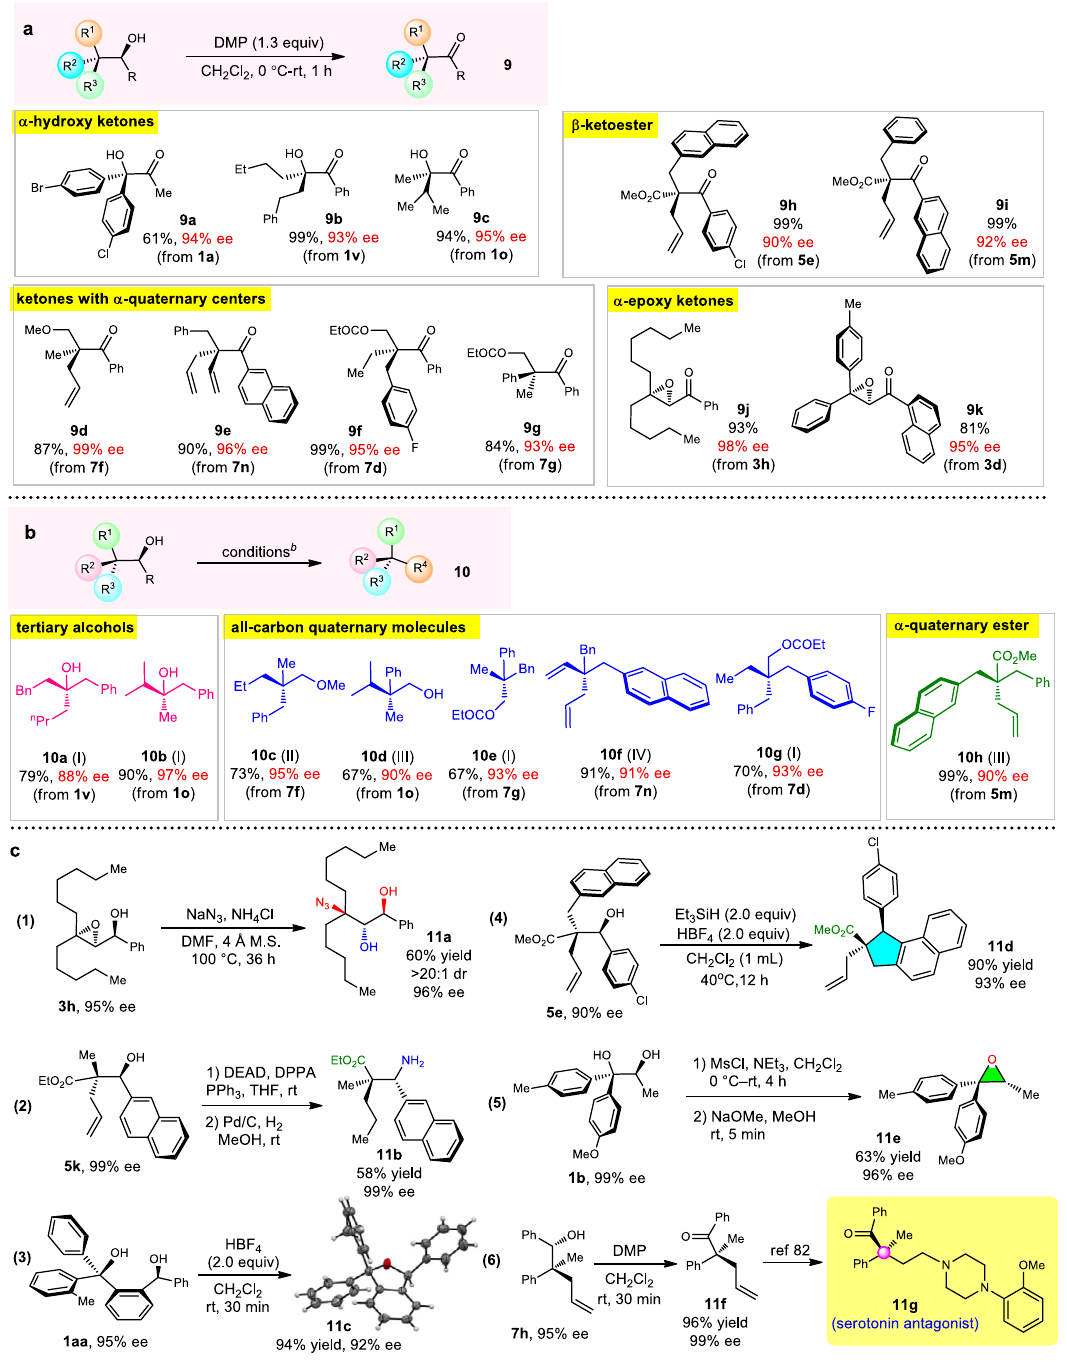
Fig. 5 Various further transformations. a Dess-Marin periodinane (DMP) oxidation. b OH group removal. Conditions I: Raney Ni (3 equiv), EtOH, re fl ux, 12 h. Conditions II: CF 3 CO 2 H (8 equiv), CH 2 Cl 2 , rt, 24 h; then H 2 , Pd/C (10 %), EtOAc, rt, 12 h. Conditions III: HBF 4 (2 equiv), Et 3 SiH (2 equiv), CH 2 Cl 2 , 40 °C, 3 h. Conditions IV: Et 3 SiH (2.5 equiv), CF 3 CO 2 H (6 equiv), CH 2 Cl 2 , 0 °C − rt, 12 h. c Various other using 1.8 g of racemic 7m also proved successful, again showing the OH group makes further transformations simple. As shown in potential of this method in big scale production. Fig. 5a, using easily operable Dess-Marin periodinane (DMP) oxidation conditions, α -hydroxy ketones with α , α -diaryl groups ( 9a ), α , α -dimethylene substituents ( 9b ), and bulky α -substituent ( 9c ) were all concisely produced without any erosion of the enantiopurity. Then a variety of ketones with all-carbon α -qua- ternary centers were also released with 93 – 99% ee (Fig. 5b, 9d – 9g ), and 9f is a ketone with three different methylene groups. Fig. 1a. To our pleasure, the readily transformable feature of the